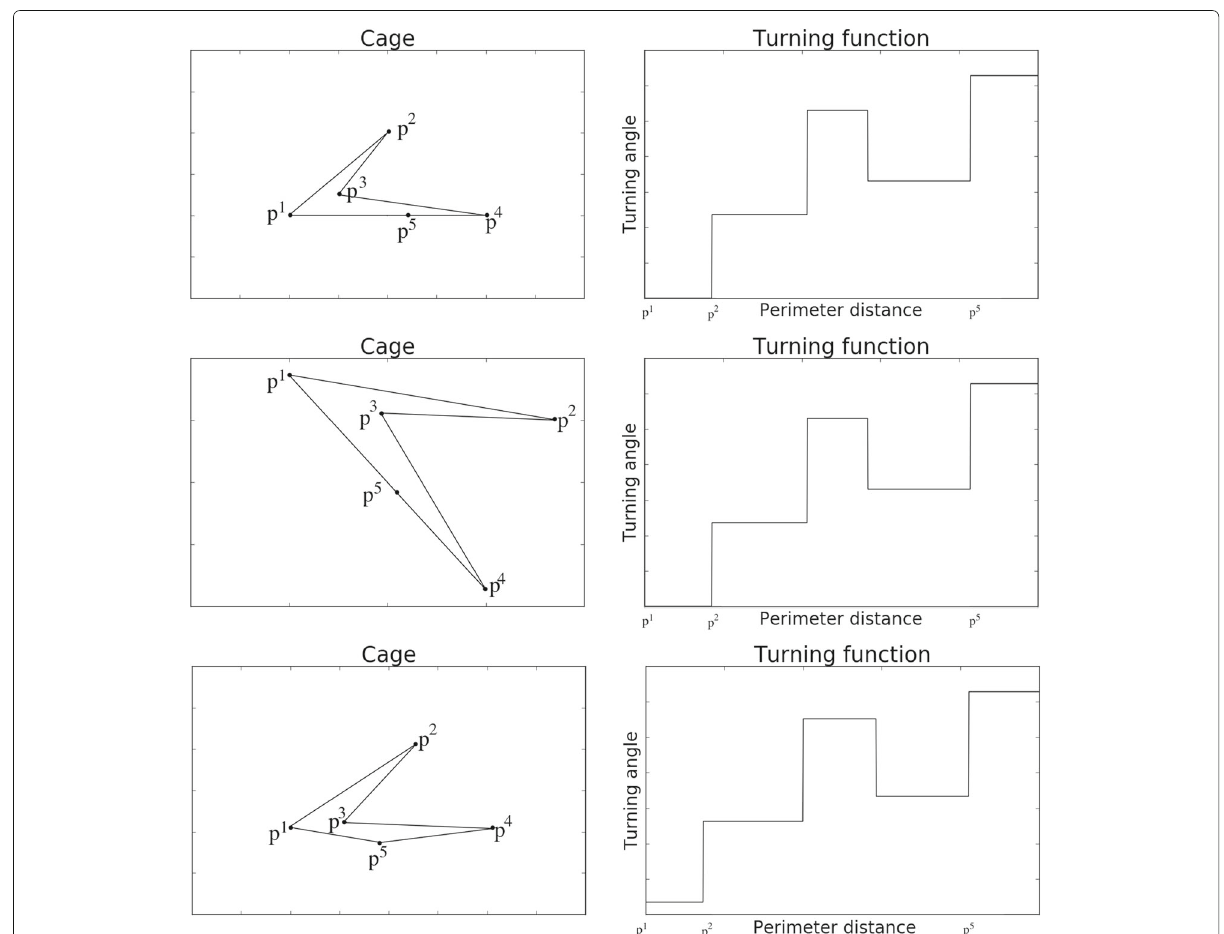
Fig. 2 Turning function. Illustration of the turning function performance for three configurations of a shape